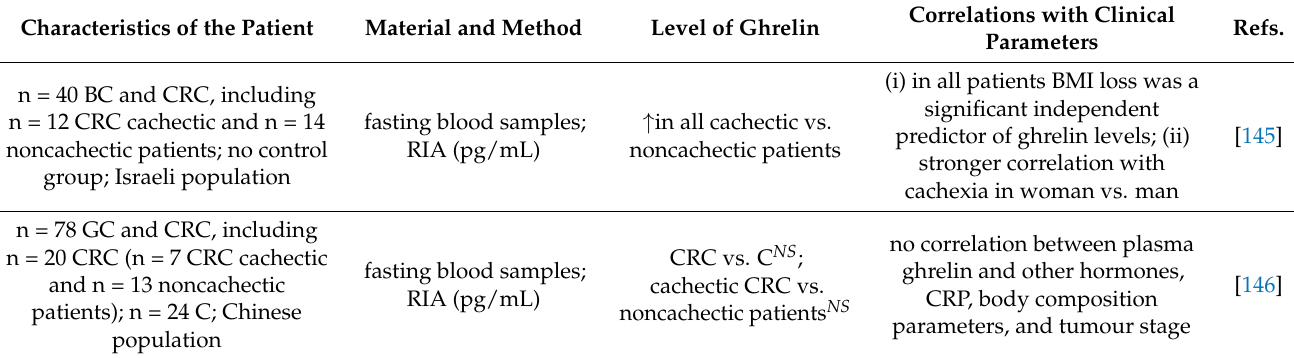
Table 1. Circulating Concentrations of Ghrelin in CRC